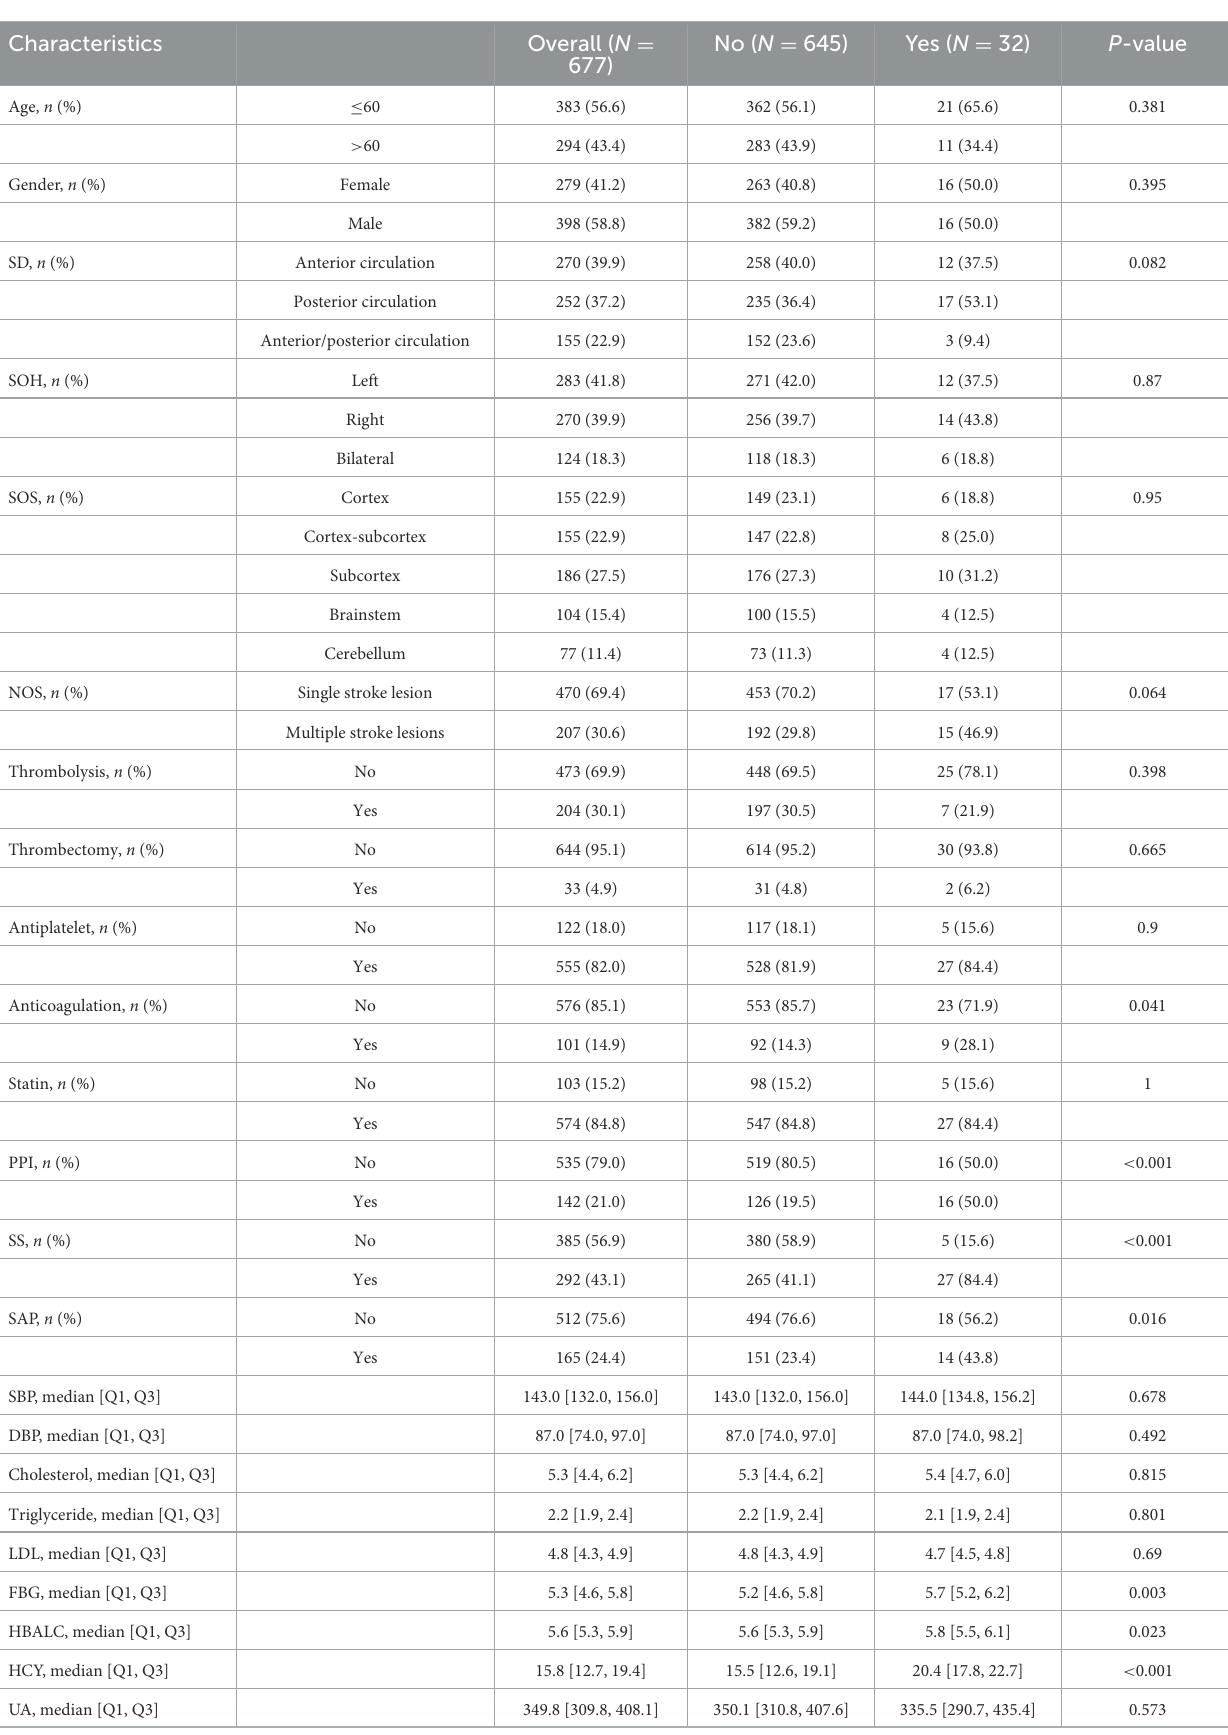
TABLE 1 Baseline table of whether stroke patients died within 1 year.